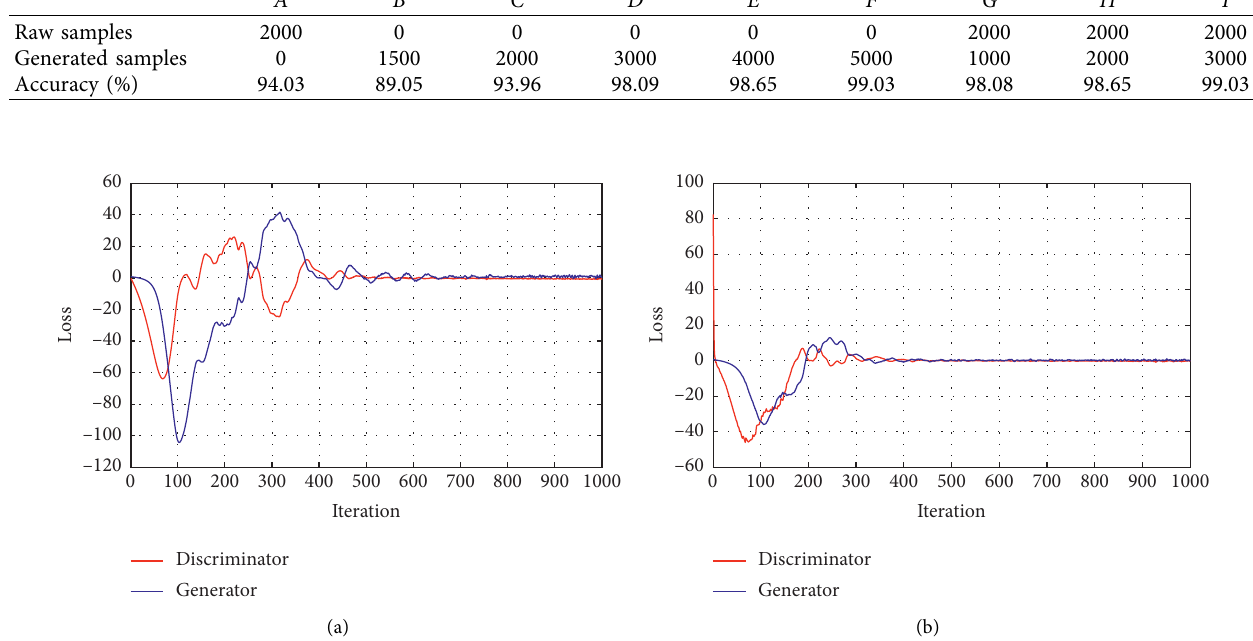
Figure 13: The loss curves of network training: (a) WGAN and (b)